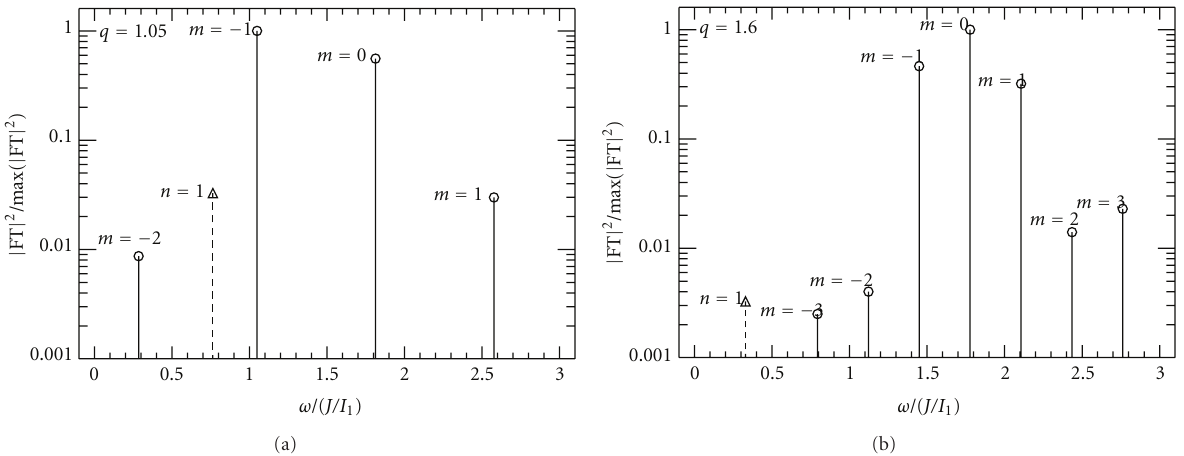
Figure 2: Normalized power spectrum of a torque-free rotating irregular grain with I 1 : I 2 : I 3 = 1:0.6 :0.5 for the di ff erent values of q = 1 . 05,1 . 60 (i.e., q < q sp ≡ I 1 /I 2 ) and q = 1 . 81 > q sp . The components of | FT(¨ μ x ) | 2 / max( | FT(¨ μ x ) | 2 ) (or | FT(¨ μ y ) | 2 / max( | FT(¨ μ x ) | 2 ) are indicated by circles, while the components of | FT(¨ μ z ) | 2 / max( | FT(¨ μ x ) | 2 ) are indicated by triangles. Orders of in-plane modes m and √ 3) of µ orientation is assumed. The figure is reproduced from Hoang et al. [15]. out-of-plane modes n are indicated, and case 1 ( μ 1 = μ/